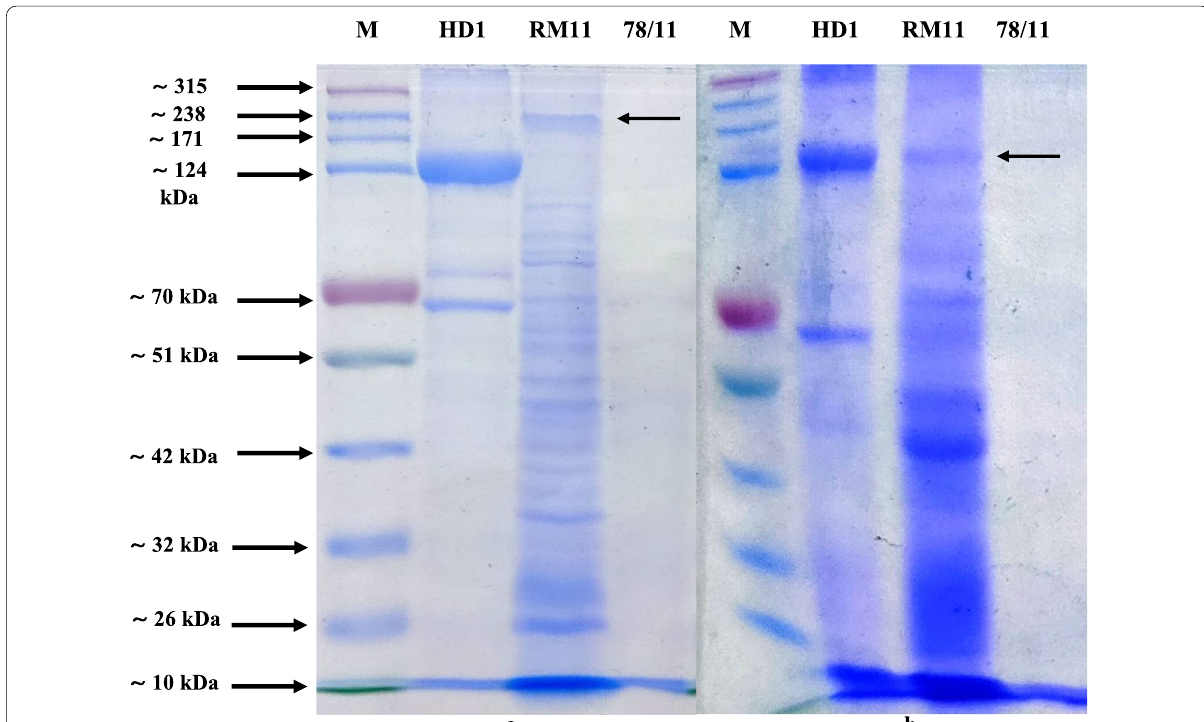
Fig. 2 Cry protein profile of Bacillus thuringiensis isolates. Lane M—protein marker. a Without solubilization, b solubilization with NaOH buffer